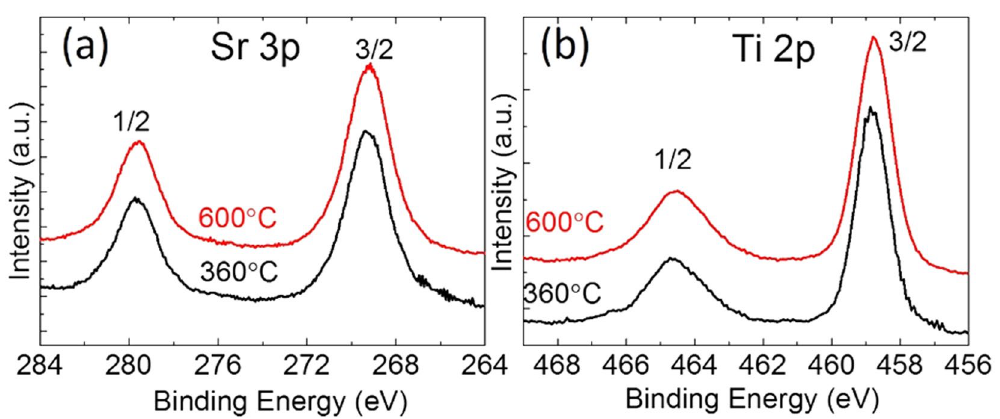
Figure 7. XPS spectra on 10 nm thick samples synthetized at 360 °C (black curve) and 600 °C (red curves). ( a ) zoom on the Sr3P region, ( b ) zoom on the Ti 2p